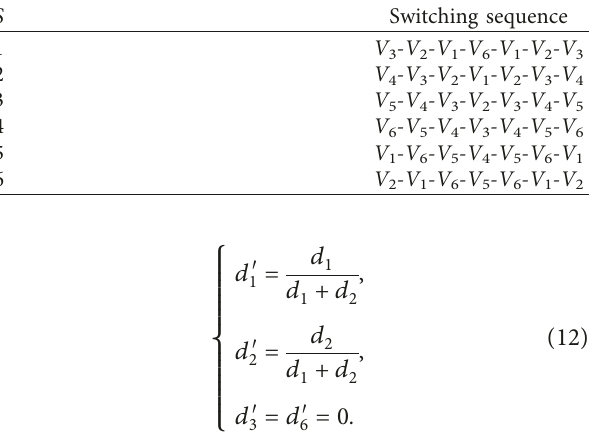
Table 2: Switching sequence design.